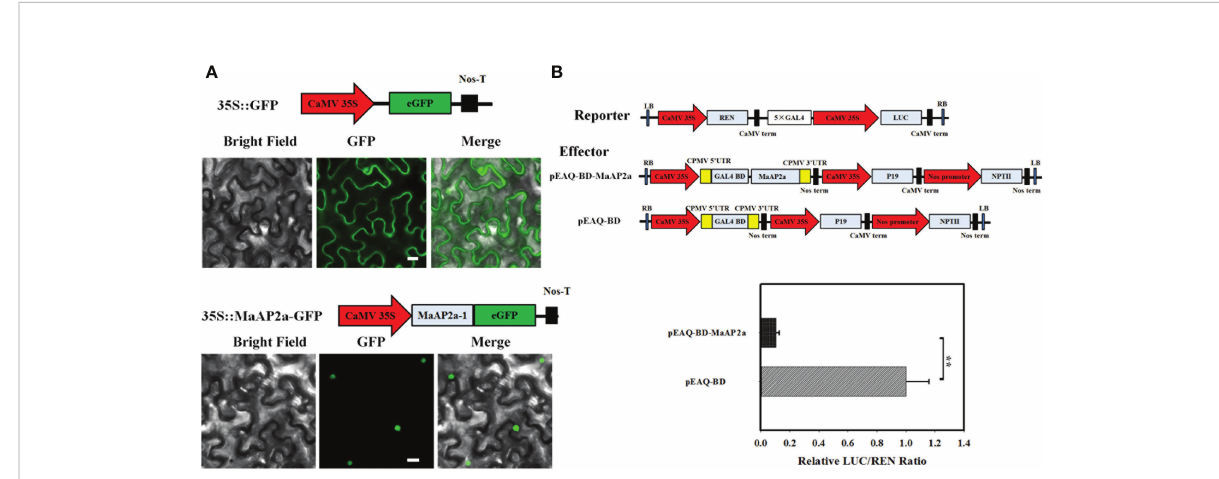
FIGURE 2 Subcellular localization and transcriptional inhibitory activity of MaAP2a in tobacco leaves. (A) Subcellular localization of MaAP2a in tobacco epidermal cells. Green fl uorescence was imaged by fl uorescence microscopy in 2 days after in fi ltration. Scale bar = 25 m m. (B) Transcriptional activity of MaAP2a in planta . Compared with the pEAQ-BD control, pEAQ-BD-MaAP2a signi fi cantly restrained the expression of the LUC reporter. The ratio of LUC to REN of the pEAQ-BD vector was used as a calibrator (value set as 1). Values represent means of six biological replicates. The ** represents signi fi cant differences in p values